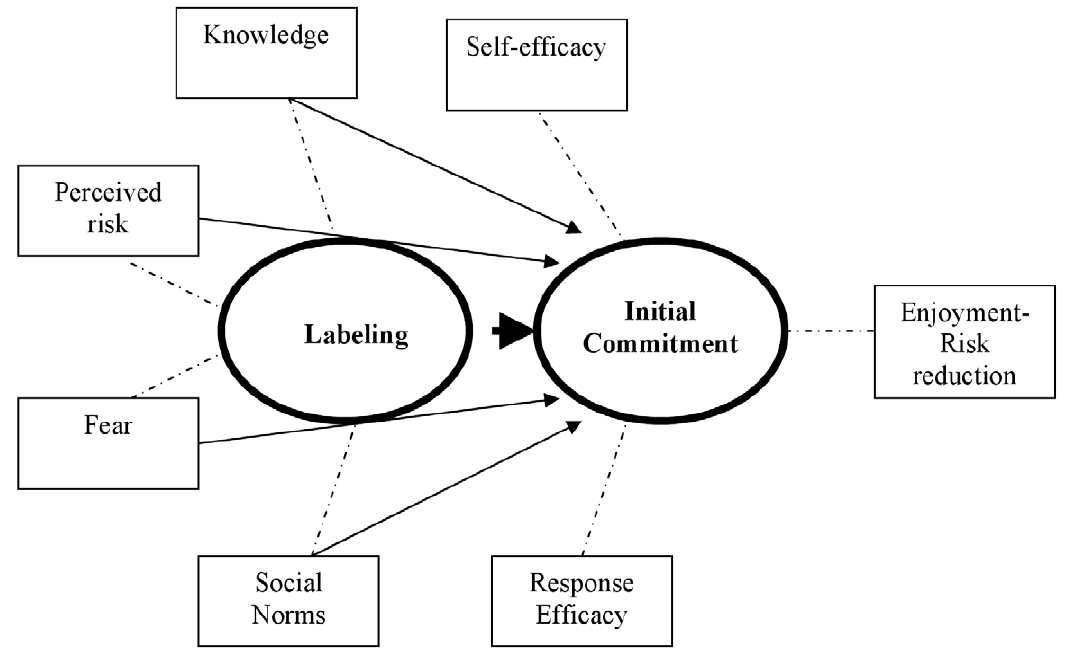
Figure 1. Conceptual framework outlining development of commitment for the use of two novel HIV prevention interventions, PREP and circumcision, through the first two stages of the AIDS Risk Reduction Model. Circles represent stages and squares represent domains of stages. Arrows represent domains/stages that affect a future stage. Dashed lines represent domains linked to stages. Labeling includes general factors that may exist in addition to circumcision and PREP. Implicit to this model is the effect of culture and geographical context on stages and domains.